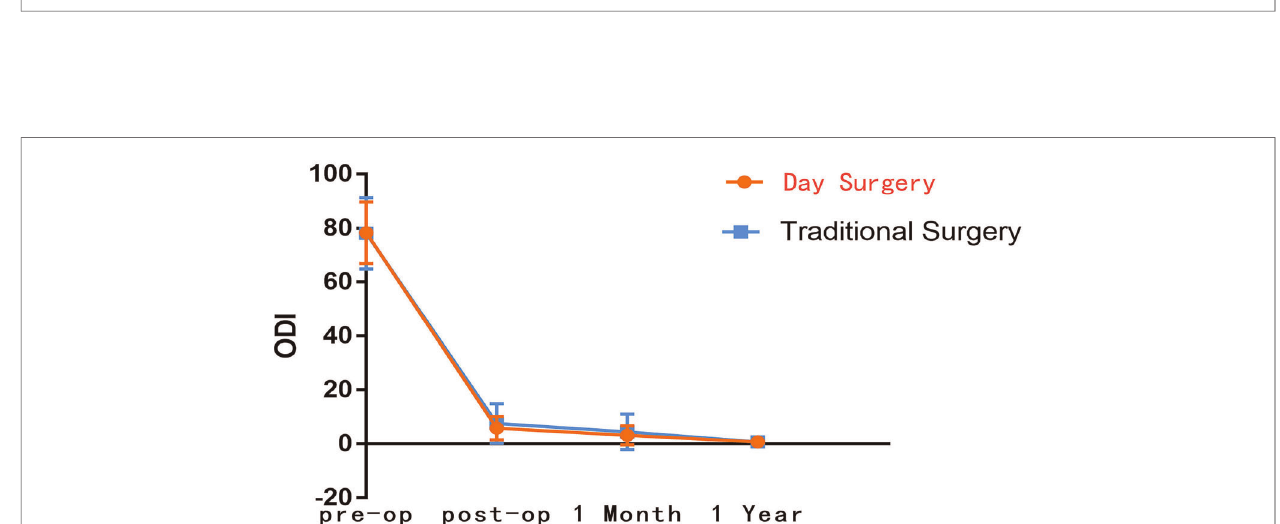
FIGURE 3 | Comparison of VAS for leg pain between DS group and TS group.